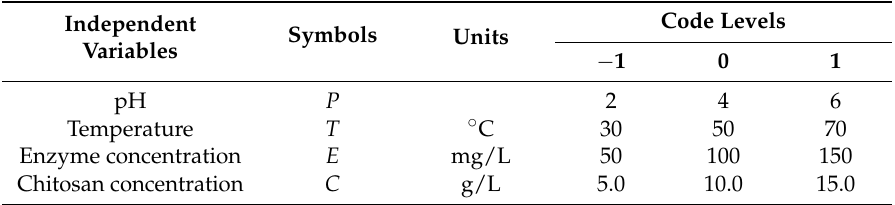
Table 1. Experimental range and levels of the independent